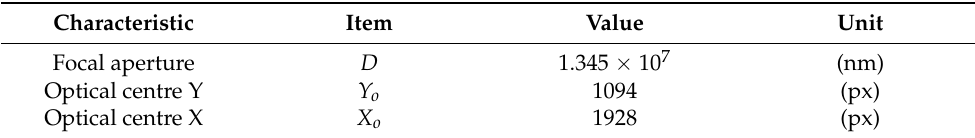
Table 1. GoPro Hero 5. Camera intrinsic characteristic.